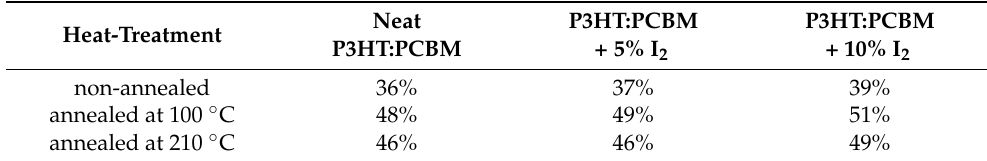
Table 1. Crystallinity of investigated thin films after heat treatment.